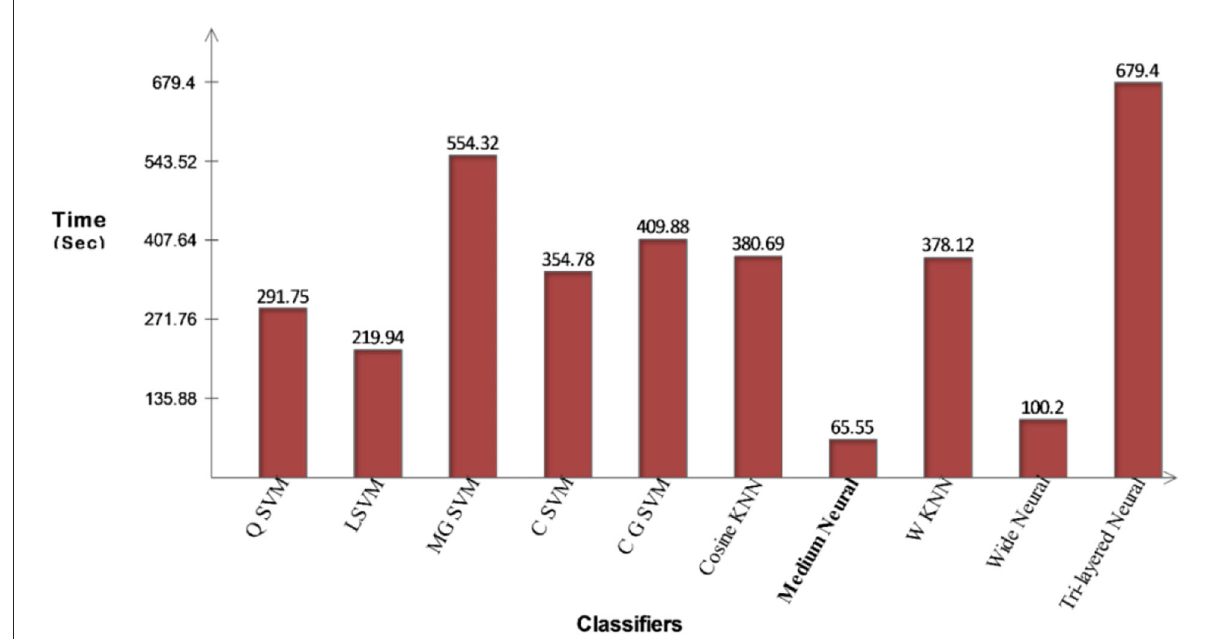
FIGURE9 Illustration of computational time for COVID-19 Radiography Database after proposed optimization method.